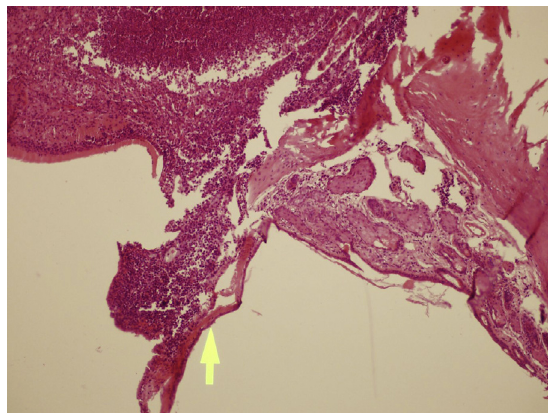
Figure 1 There is no significant tympanosclerosis (arrow) in this sample of control group; with moderate otitis media (left side of arrow). H&E stain, 100 × magnification.